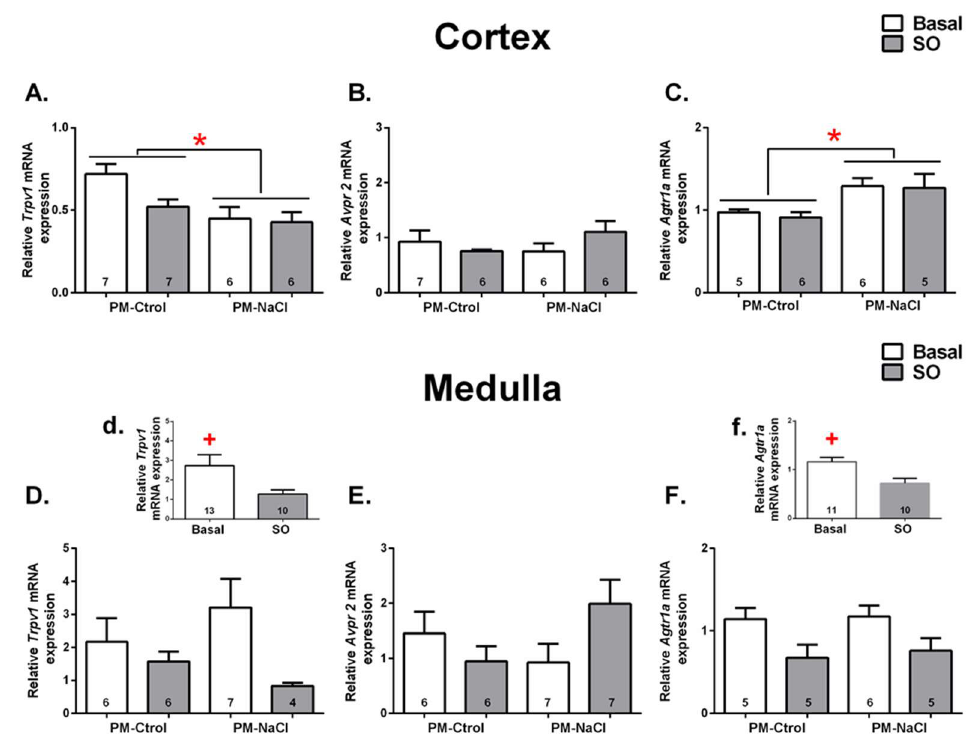
Figure 4. Sodium programming effects on renal mRNA expression of receptor potential vanilloid type 1 (Trpv1), vasopressin receptor type 2 (Avpr2), and angiotensin receptor type 1a (At1a), in response to sodium overload (SO). Relative levels of Trpv1 ( A , D,d ), Avpr2 ( B , E ), and Agtr1a ( C , F , f ) mRNA in renal cortex ( A – C ) and medulla ( D , d , E , F , f ) of male PM-Ctrol and PM-NaCl animals under basal conditions (basal), and after SO. The numbers inside the bars represent the number of animals in the group. + significant difference at p < 0.05 between SO and basal groups; * significant difference at p < 0.05 between PM-Ctrol and PM-NaCl groups .